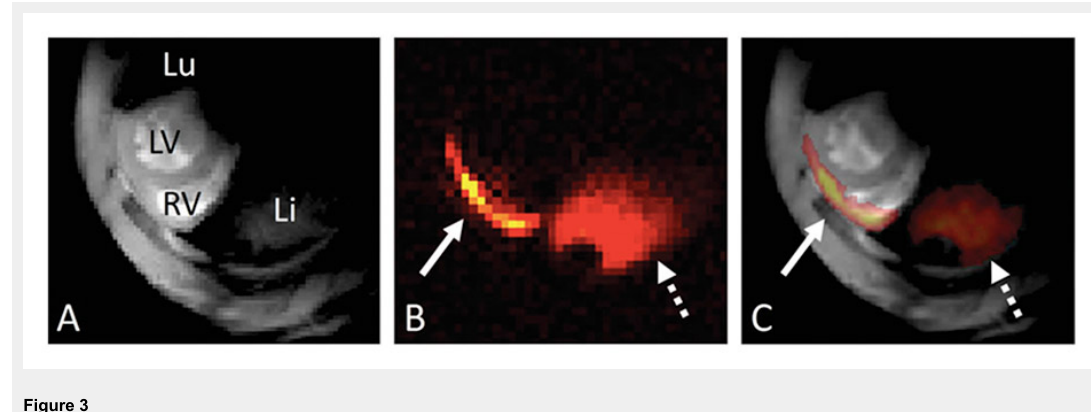
Figure 3 Fluorine-19 magnetic resonance imaging of myocarditis. (A) 1 H magnetic resonance imaging (MRI) slice in the short-axis orientation at the base of the heart in the experimental autoimmune myocarditis mouse model; 1 H-MRI depicts the right and left ventricles (RV and LV) as well as the lung (Lu) and liver (Li). (B) 19 F-MRI of the same anatomical location. Two regions with a 19 F signal can be observed: a thin line at the level of the myocardium (whole arrow) and a larger region at the level of the liver (dotted arrow). (C) Fusion of the 1 H and thresholded 19 F images: the 19 F signal collocalises with the RV free wall and the liver (reproduced from